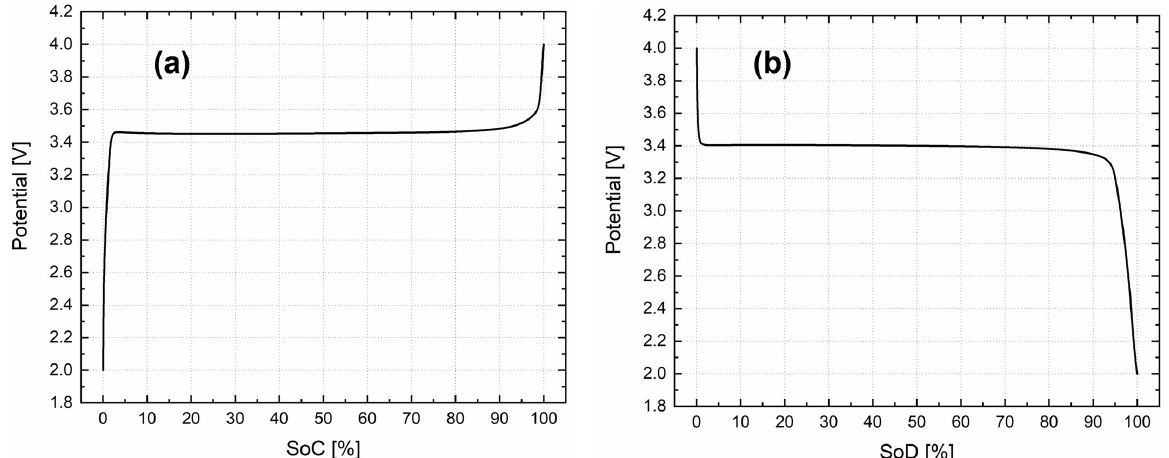
Figure 2. Open-circuit voltage of LFP, ( a ) charge and ( b ) discharge.